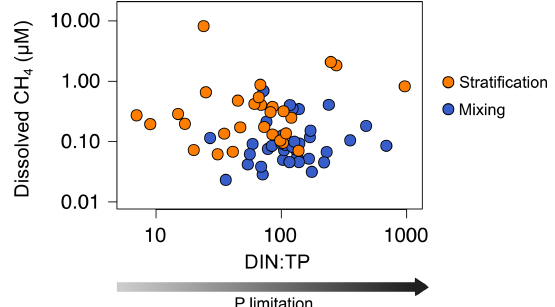
Figure 7. Phosphorus limitation and the dissolved CH 4 concentra- tion in the oxic waters. Scatterplot of dissolved CH 4 concentration and the ratio between dissolved inorganic nitrogen (DIN) and the total phosphorus (TP) (µmolN:µmolP). Note the logarithmic scale in both